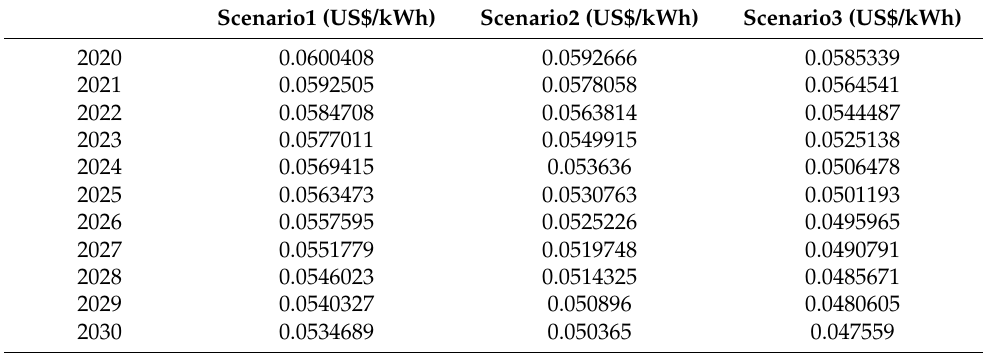
Table 4. Cost of CPV power under baseline.